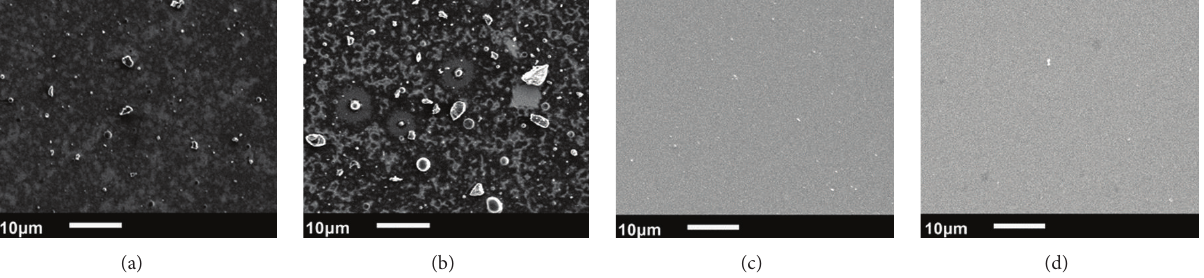
Figure 2: SEM micrograph ( × 1000) of deposited films: (a) boron 355 nm, (b) boron 1064nm (c) tungsten 1064 nm, and (d) tungsten 355 nm. 𝐹 = 10 J/cm 2